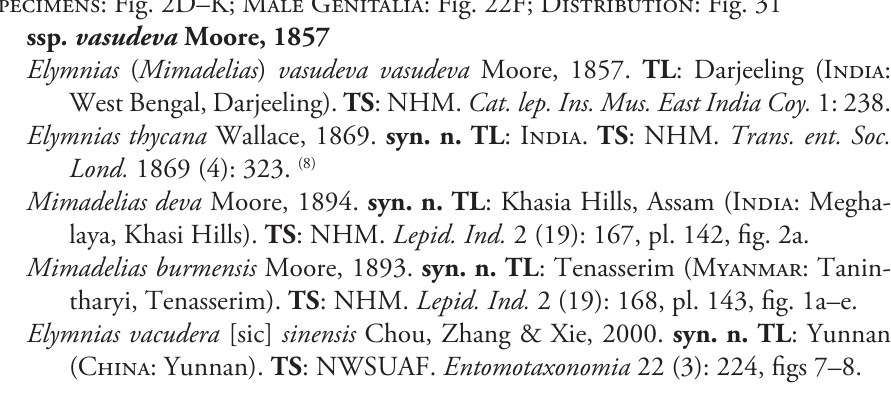
Specimens: Fig. 3A–D; Male Genitalia: Fig. 22G–I; Distribution: Fig.